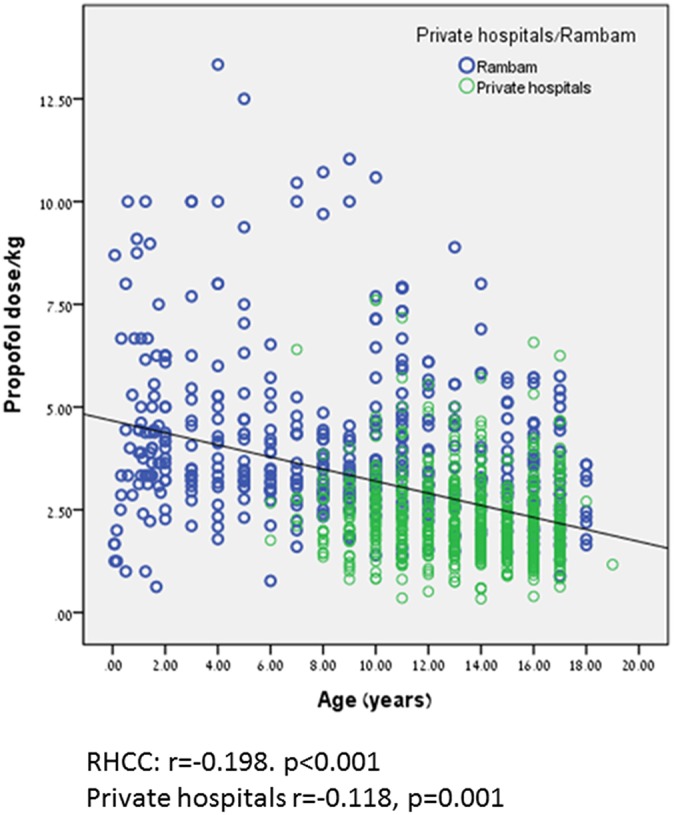
Relation between procedure location and propofol dose/kg.